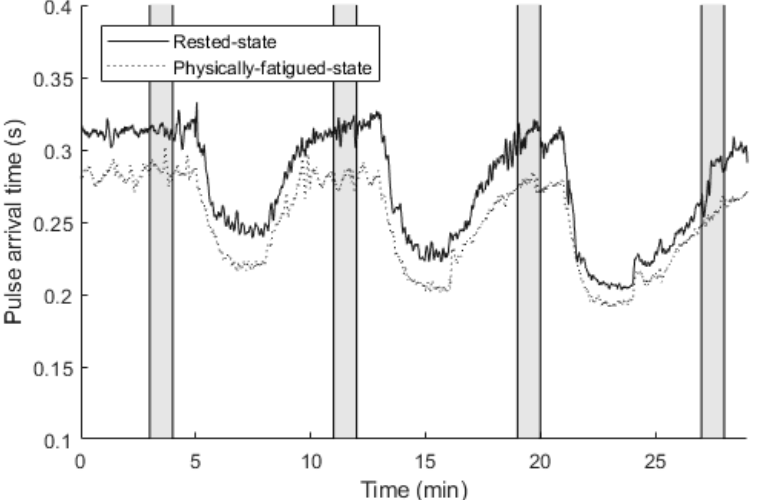
Figure 4. Pulse arrival time of a subject (before normalizing with blood pressure) during veloergometer test in the rested state and the physically fatigued state. Parameter values were calculated based on the grayed areas.